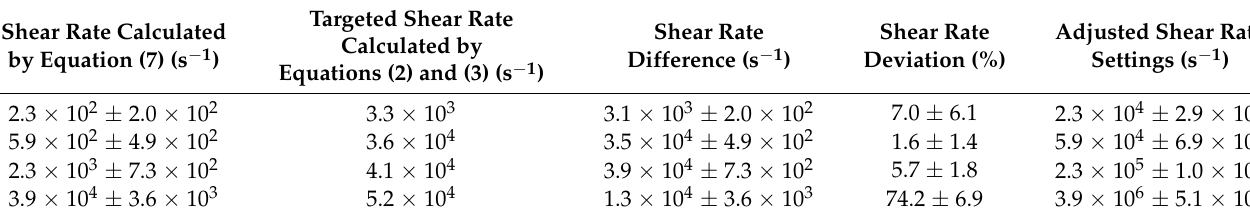
Table 4. Shear rates in the shear pump calculated with fit Equation (7) (mean of MC88 and MPC85 ± standard deviation) compared to targeted shear rates calculated by Equations (2) and (3). The shear rate deviation between calculated and targeted (percentage of the targeted shear rate) specifies by which shear rate the shear rate calculated by Equations (2) and (3) had to be increased to reach the targeted shear rates of the pilot scale conditions. This gives the adjusted shear rate settings. Shear Rate Calculated by Equation (7) (s − 1